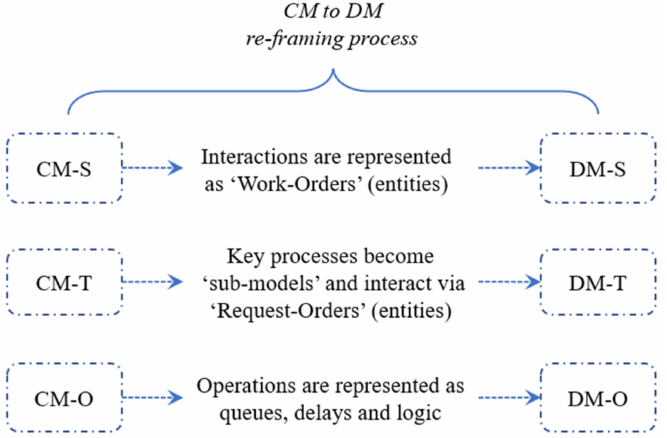
Figure 13. Converting the Conceptual Model to a Design